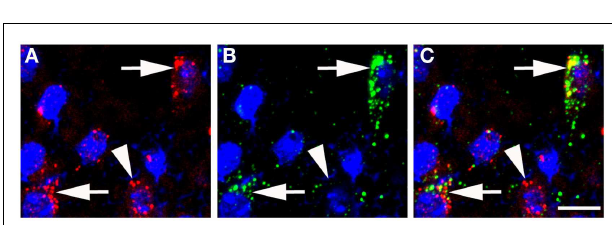
FIGURE 4 | Colocalization ofVGluT2 mRNA and PTH2R mRNA in the anterior hypothalamus as detected by fluorescent in situ hybridization. (A) VGluT2 mRNA (red puncta) over cell nuclei (blue, DAPI). (B) PTH2R mRNA (green puncta) over cell nuclei (blue, DAPI). (C) a merged image, where the arrows point to cells expressing both PTH2R/VGluT2 mRNAs and the arrowhead points to a neuron with onlyVGluT2 signal. Scale bar = 10 µ m.